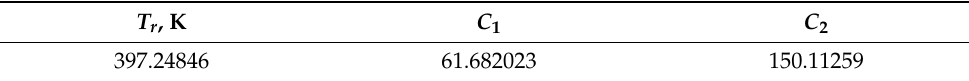
Table 7. Values of viscoelastic constants of the relaxation function for 10 relaxation times.